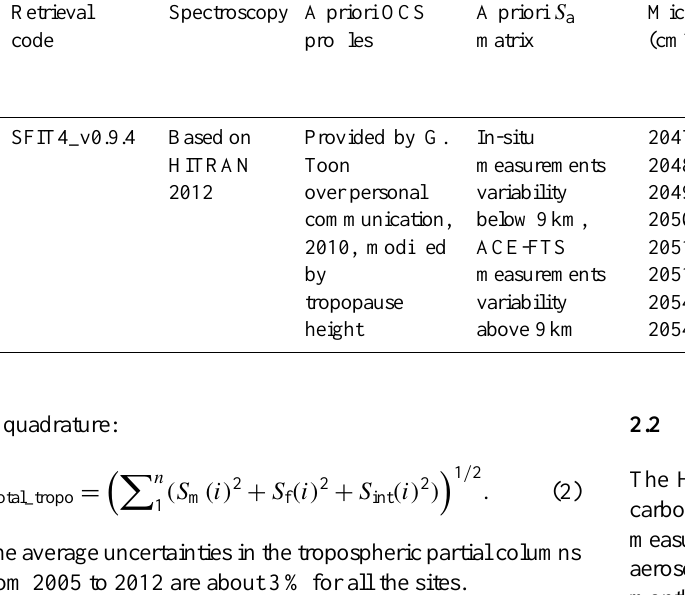
Table 2. Summary of the retrieval parameters for OCS.